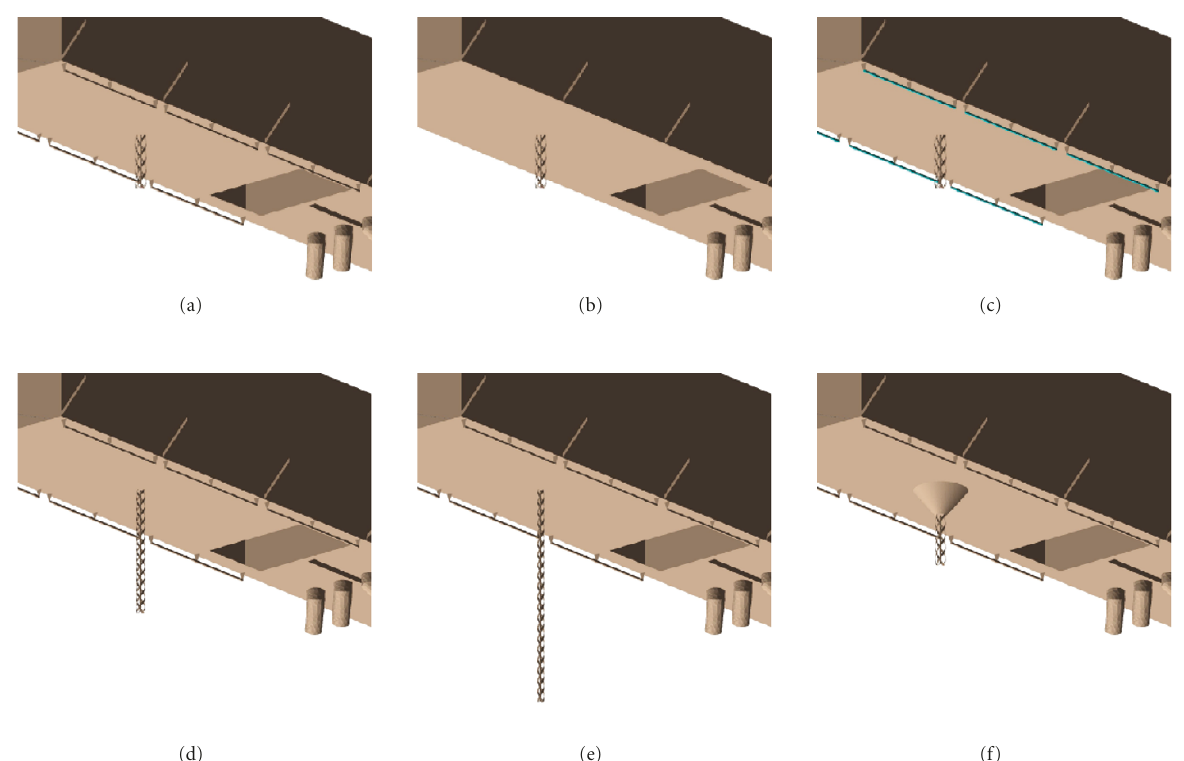
Figure 8: FEKO models of helical antenna variations; (a) single turn, (b) no ground handling bars, (c) plastic ground handling bars, (d) 3-turn helix, (e) 5-turn helix, (f) single turn helix on stando ff cone.